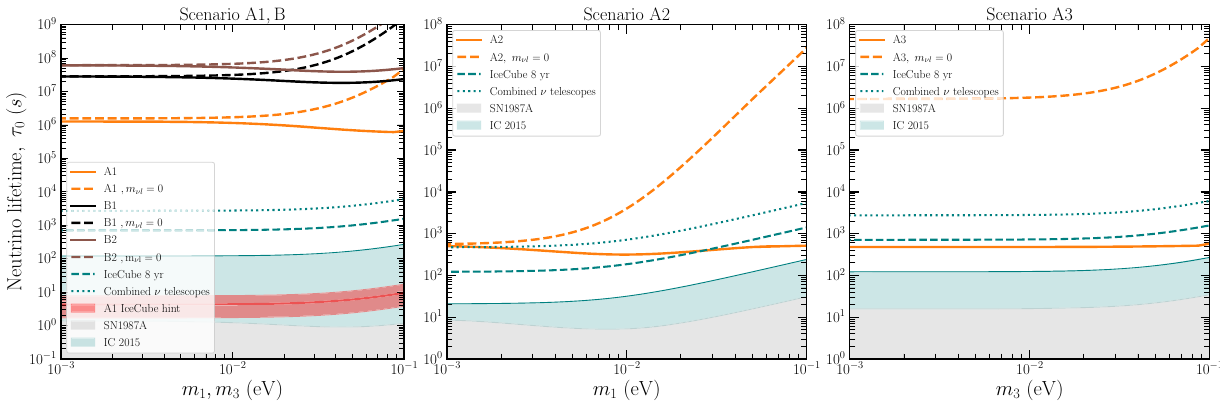
Fig. 3 Lower bounds on the neutrino lifetime converted from the 95% credible limits on the effective transport rate Y (Table 2) for the three single-decay-channel cases of scenario A and the two two-decay- channel cases of scenario B (see Table 1), as functions of the lightest neutrino mass m 1 (NO) or m 3 (IO). Orange (black) solid lines denote the revised bounds of this work for scenarios A (B), while the dot- ted lines represent the naïve constraints we would have obtained had we assumed a massless daughter neutrino m ν l = 0 in the phase space factor (cid:18)( m ν l / m ν H ) (Eq. (17)). The interpretation of these bounds in conjunction with Table 1 is unambiguous in scenario A. In scenario B1 the bounds apply to ν 3 , while in B2 they apply to both ν 1 and ν